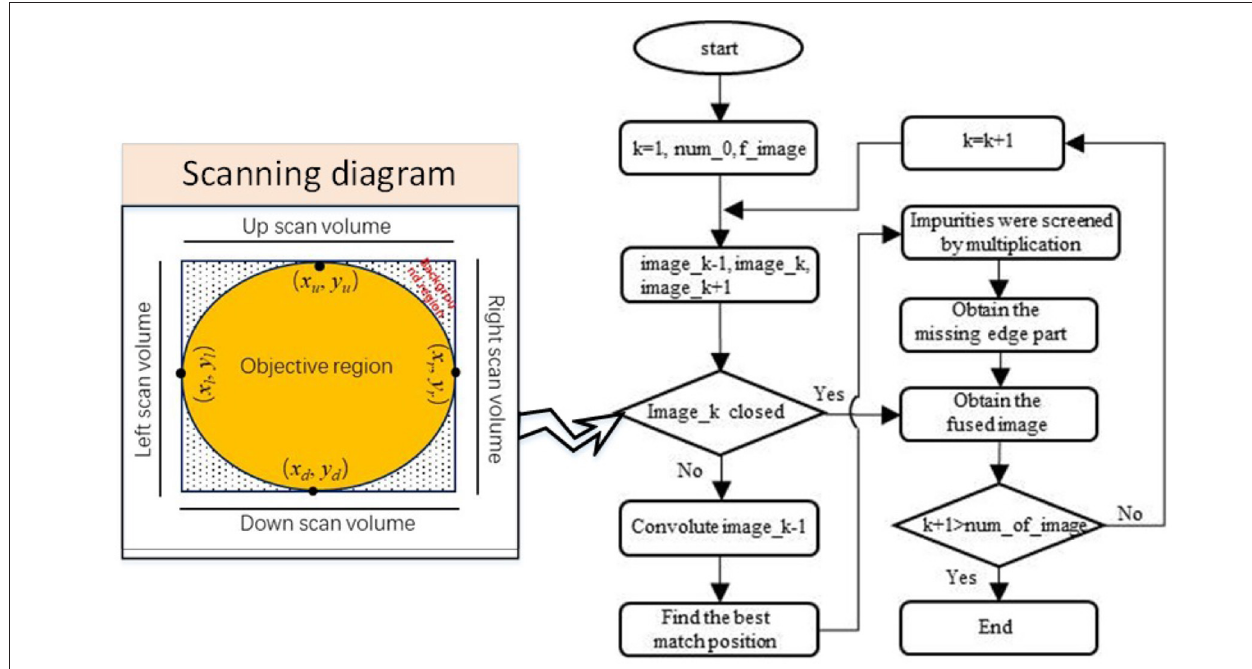
FIGURE 4 | The flow chart of the edge feature continuity processing.